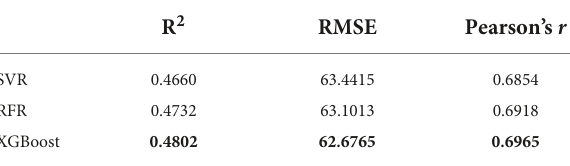
TABLE 3 Comparison of the ability to predict and fit of the three